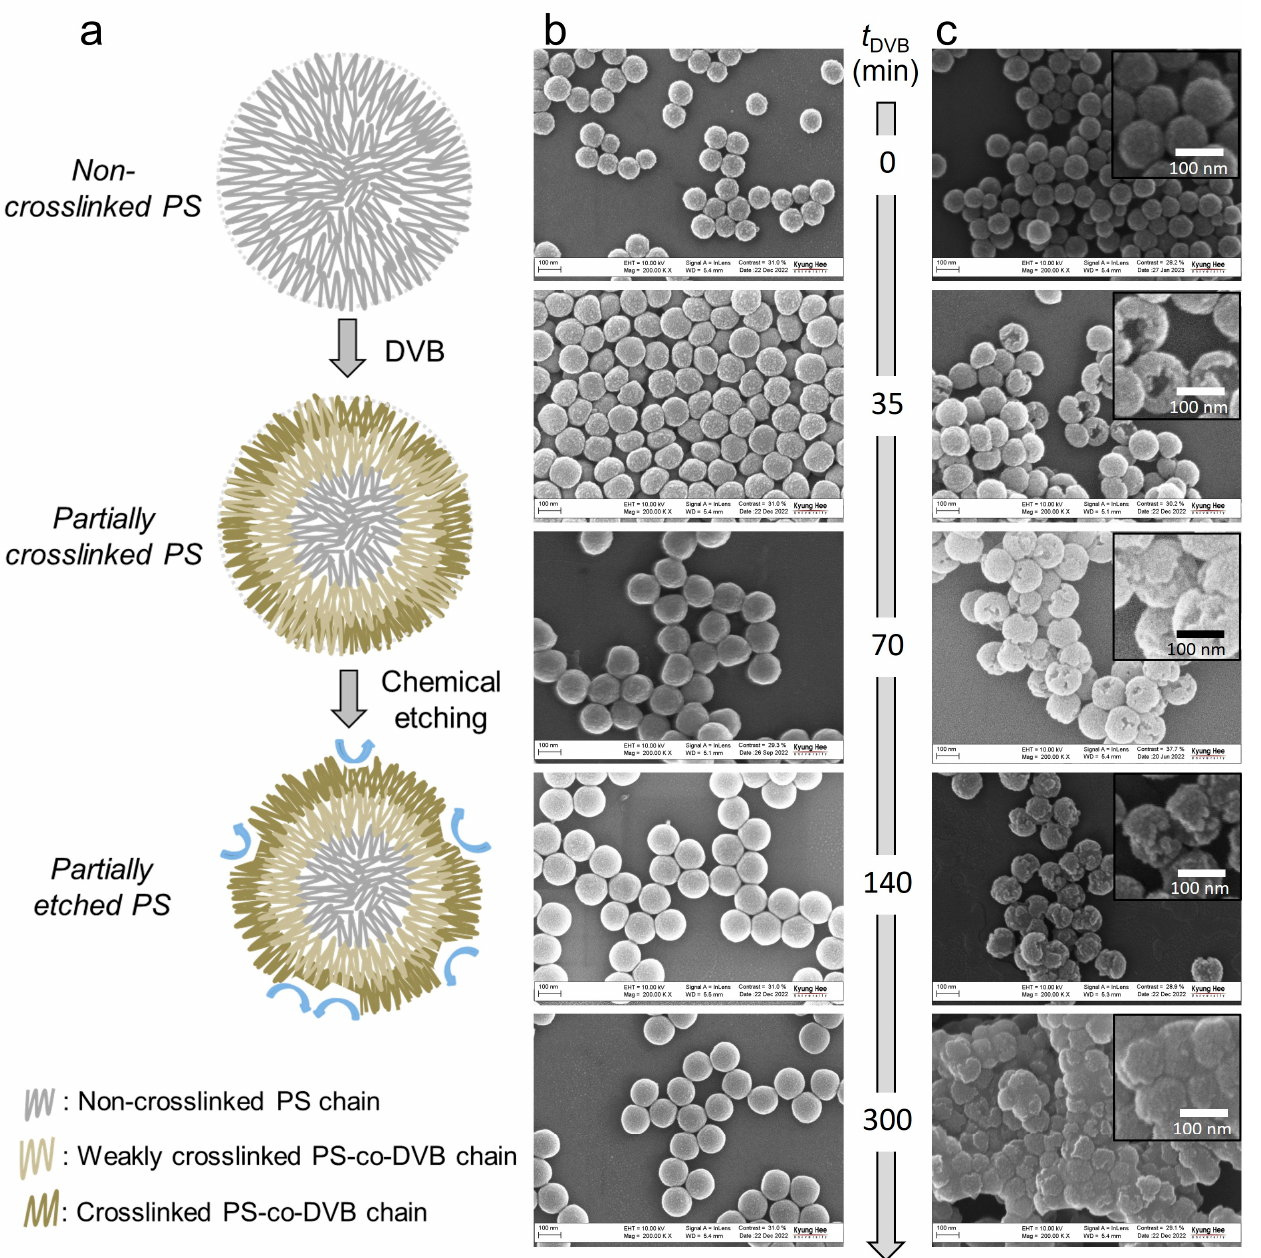
Figure 3. Formation of partially etched PS NPs. ( a ) Schematic for illustrating the prospective mechanism. ( b , c ) SEM images showing morphological changes before ( b ) and after ( c ) chemical etching with toluene depending on t DVB (SDS was used). Insets in panel c indicate the corresponding magnified